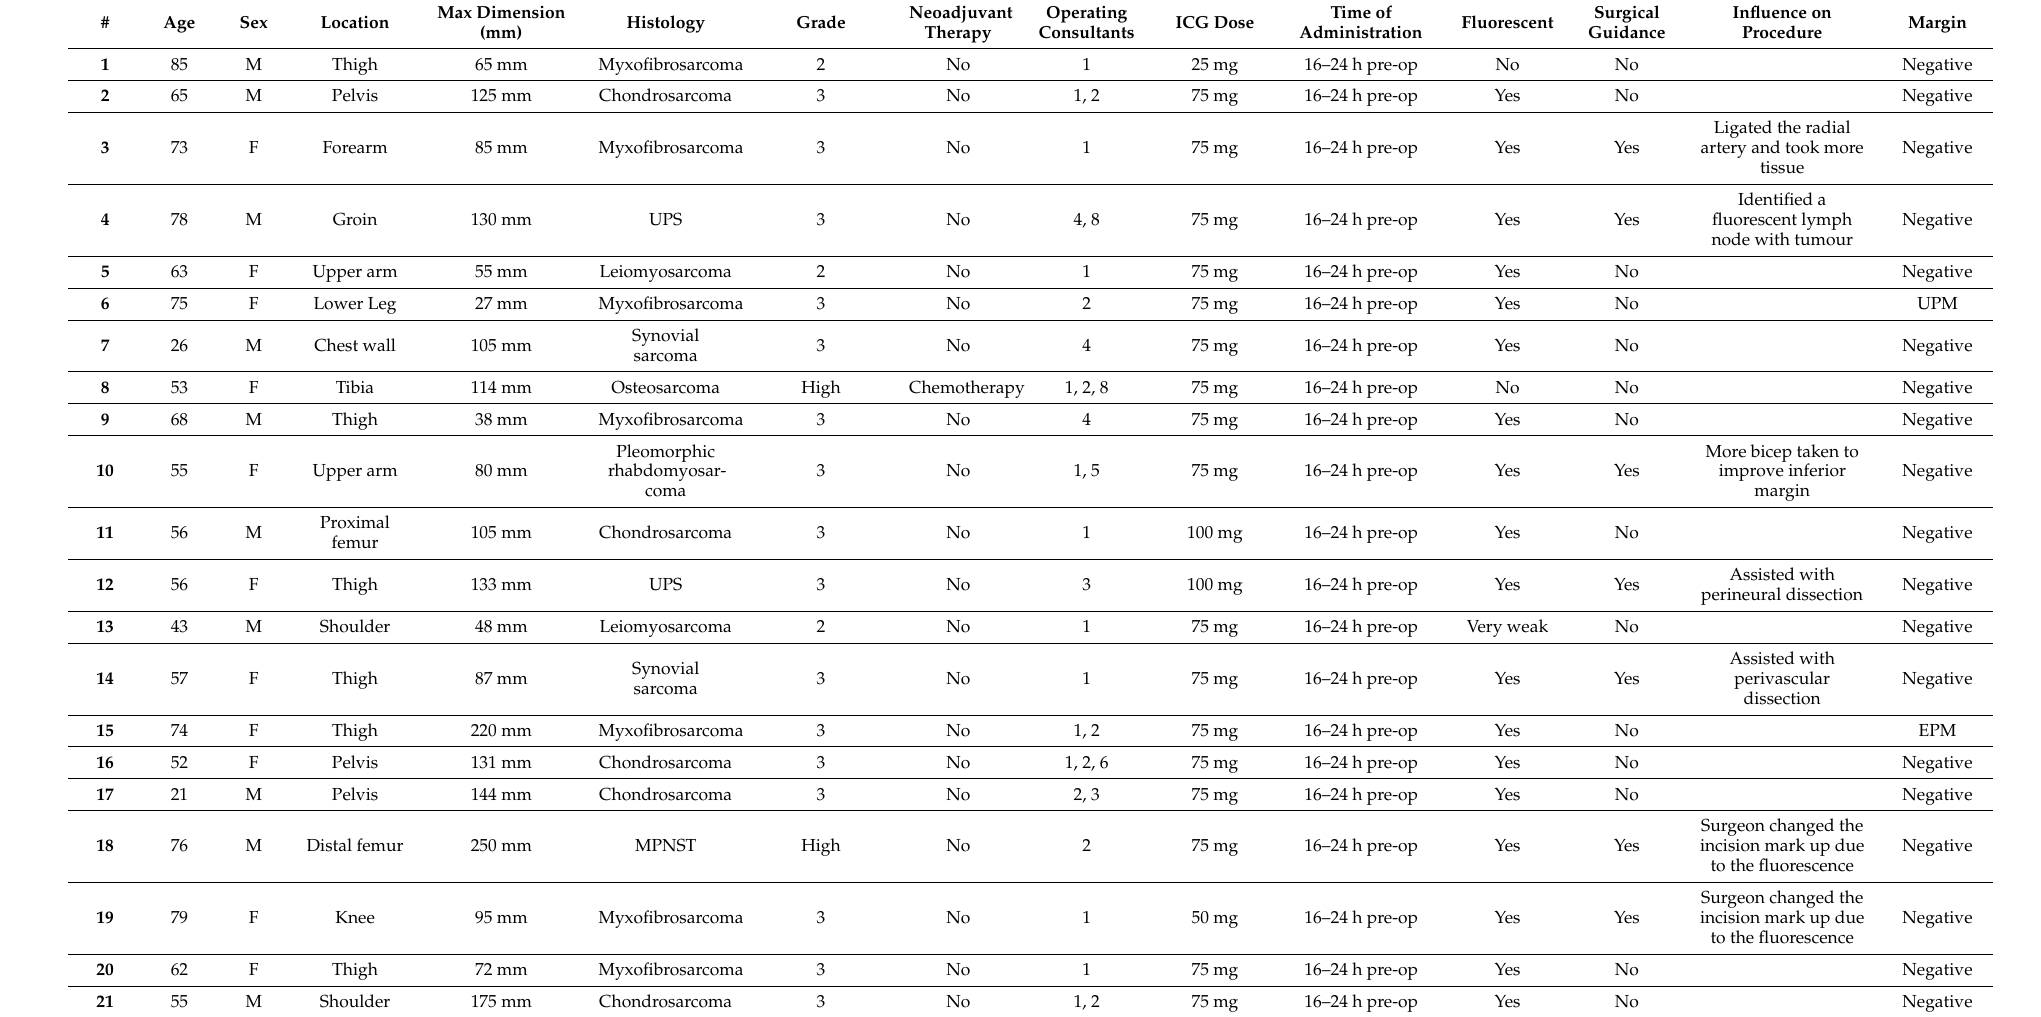
Table 2. Extended clinical information for patients receiving ICG